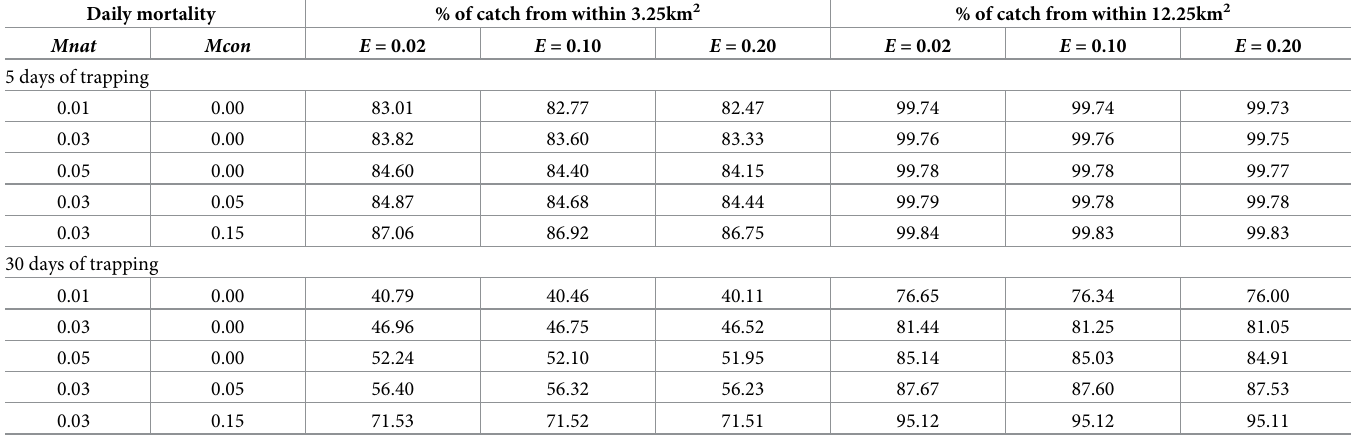
Table 1. The percentage of the cumulative catch originating from within given circular areas around a single trap, when various values were ascribed to the parame- ters Mnat (natural morality), Mcon (control morality) and E (catching efficiency), in five or 30 days of trapping. Daily mortality % of catch from within 3.25km 2 % of catch from within 12.25km 2